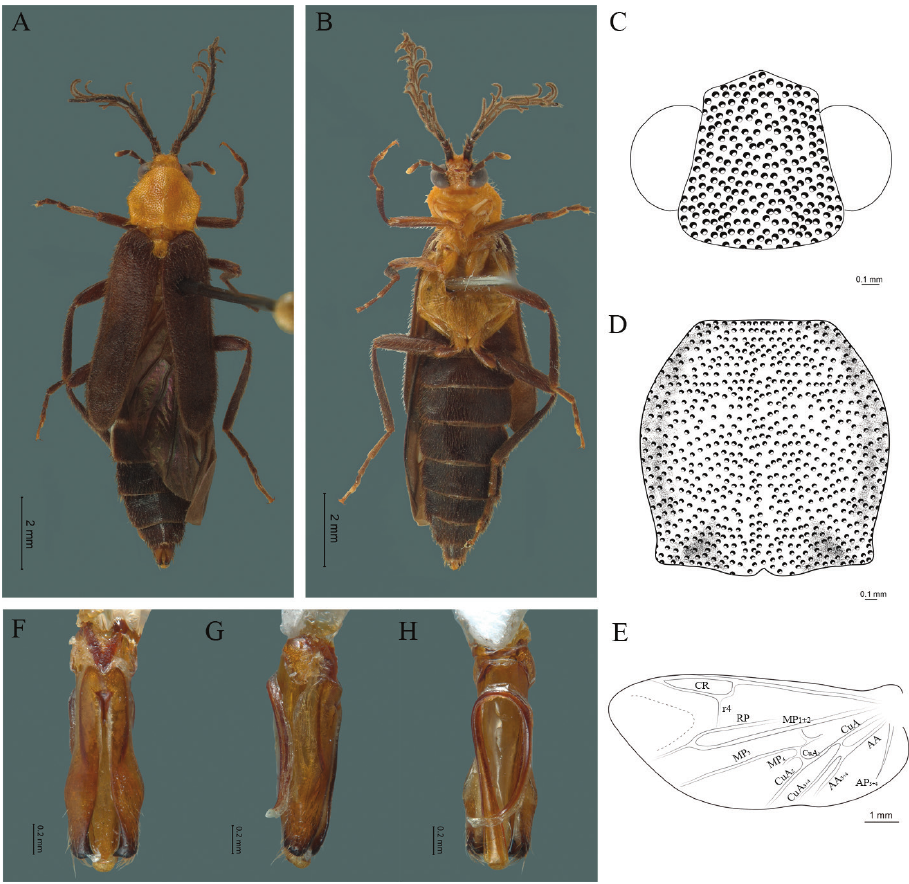
Figure 15. Cenophengus magnus Zaragoza-Caballero, 1988, male. Habitus: A dorsal B ventral C head dorsal D pronotum dorsal E hind wing. Wing venation: CR = Radial Cell; r4 = radial 4 vein; RP = Posterior Radial vein; MP1+2 = Posterior Median vein; CuA = Cubital vein; AA and AP = Anterior and Posterior Anal veins. Aedeagus: F dorsal view G lateral view H ventral